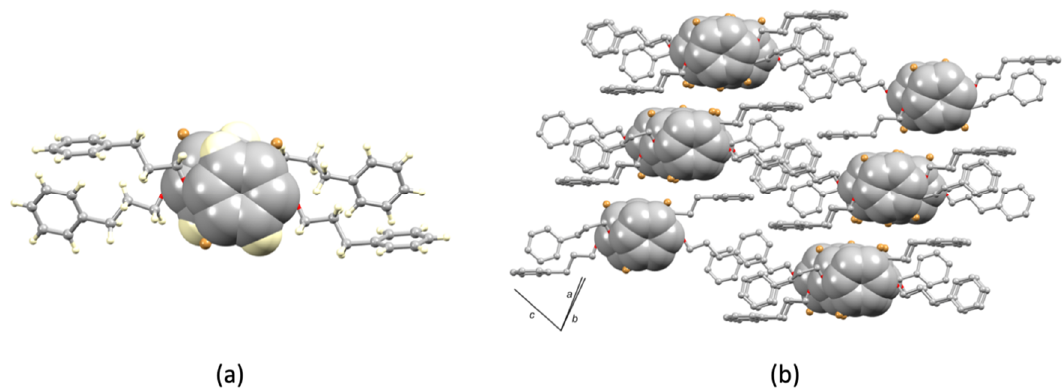
Figure 4. ( a ) π-Stacking between the two crystallographically independent molecules of 2 with the C and H atoms of the stacked rings shown in space-filling representation. ( b ) Extension of the same π-stacking contacts through the lattice (H atoms are omitted for clarity).